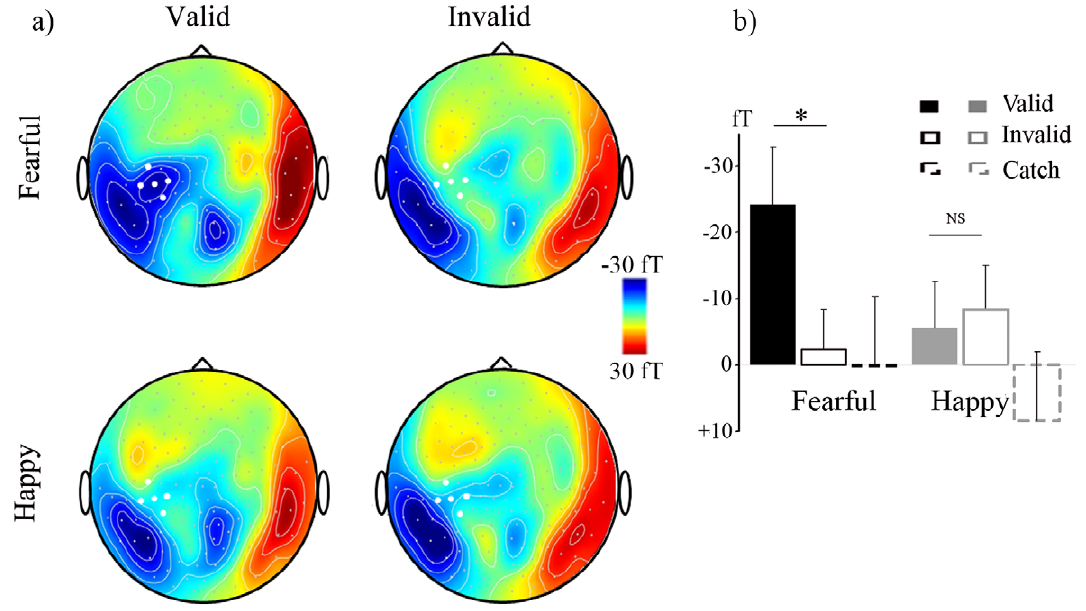
Figure 2. Early (55–70 ms) attention orienting effect induced fearful gaze. a) Grand mean maps of the mean amplitude of ERF in response to targets between 55 and 70 ms, under the four experimental conditions of cue-target validity and emotion. The white dots represent the 5 parietal sensors of measurement. b) Bar plots of the mean amplitude of ERFs on the five sensors of measurement between 55 and 70 ms, for valid, invalid, and catch trials following fearful and happy gaze cues. The bars represent grand mean values, and the lines represent the standard error of the mean. (Figure 2). Thus, we focused our analysis on this activity, as observed on the grand mean of the ERFs: we measured the mean amplitude of magnetic responses between 55 and 70 ms on five parietal sensors centred on this activity.